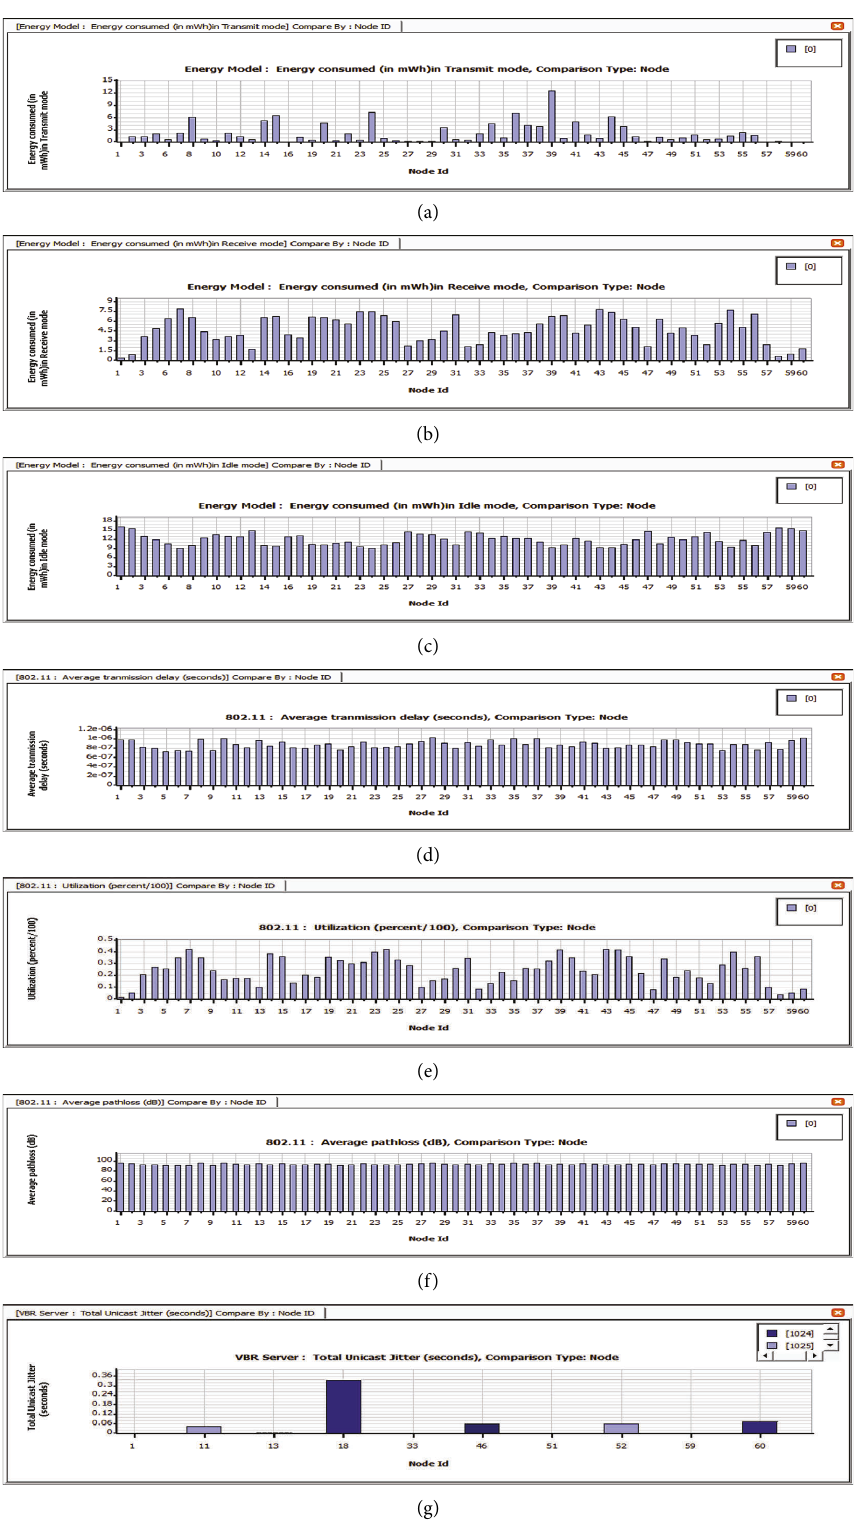
Figure 25: (a)Transmit mode energy consumption of Fisheye for VBR deployment. (b) Receive mode energy consumption of Fisheye for VBR deployment. (c) Idle mode energy consumption of Fisheye for VBR deployment. (d) Average transmission delay of Fisheye for VBR deployment. (e) Percentage of utilization of Fisheye for VBR deployment. (f) Average pathloss of Fisheye for VBR deployment. (g) Average jitter of Fisheye for VBR